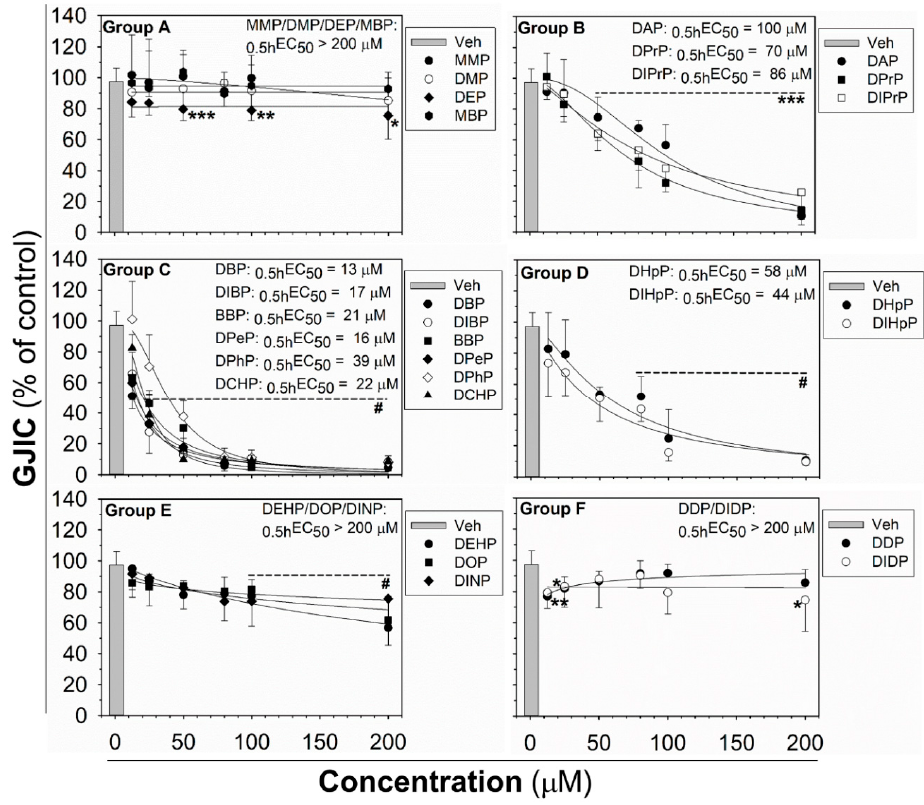
Figure 1. Concentration-dependent effects of phthalates on liver gap junctional intercellular communication (GJIC) in rat oval WB-F344 cells after 0.5 h treatment. The studied phthalates were distinguished into six groups (group A – F ) based on their biological activities, structures, and physico–chemical properties. Data represent the means (SD) of independent experiments ( n > 3). Significant di ff erences from the vehicle control were determined by one-way ANOVA (*, p ≤ 0.050; **, p ≤ 0.01; ***, p ≤ 0.001) or Kruskal–Wallis ANOVA (#, p ≤